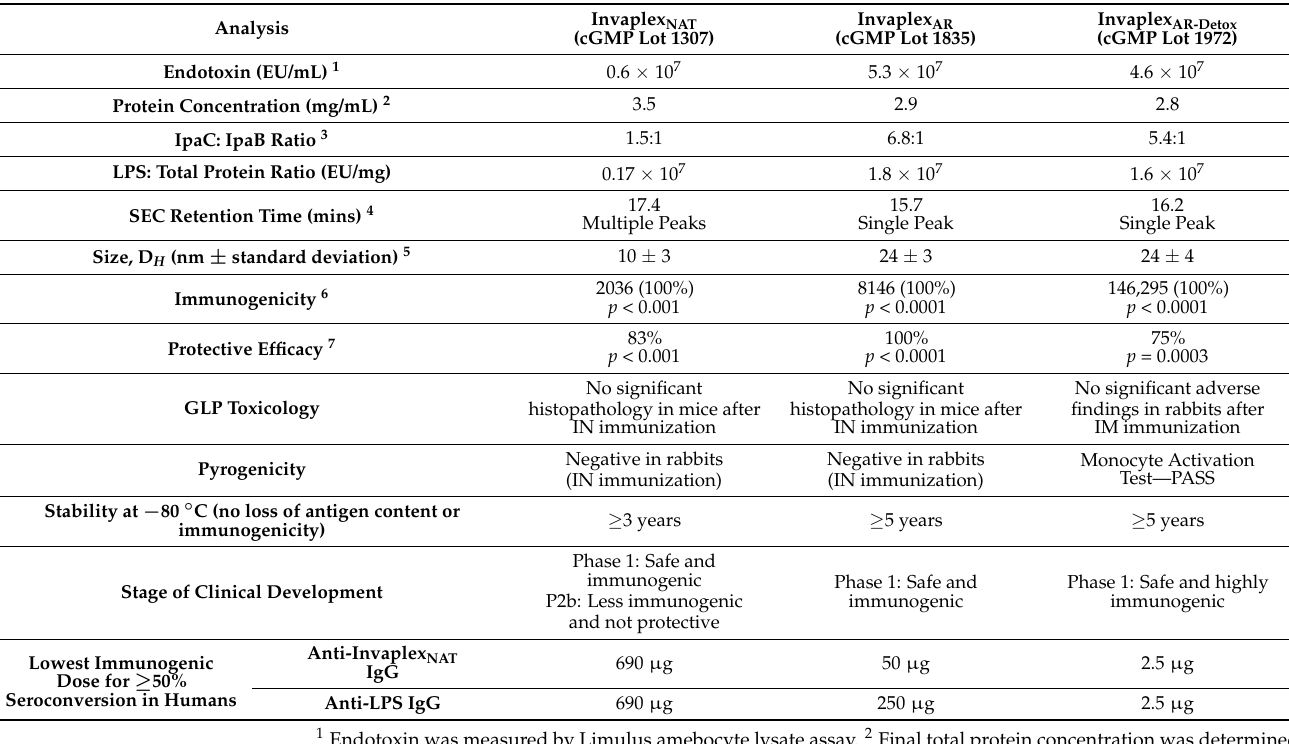
Table 2. Comparison of cGMP S. flexneri 2a Invaplex